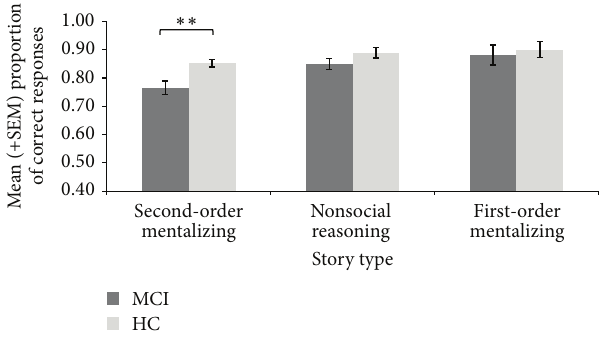
Figure 1: Mean ( ± SEM) proportions of correct scores on second- order mentalizing, nonsocial reasoning, and first-order mentalizing of the Combined Stories Test. MCI = elderly persons with mild cognitive impairment; HC = healthy controls participants; SEM = standard error of the mean ∗∗ 𝑝 < 0.01